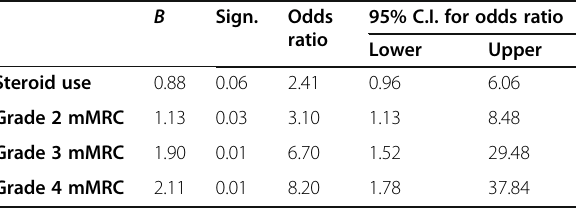
Table 3 Logistic regression analysis for effect of steroid use and grade of dyspnoea on development of moderate or severe post-COVID